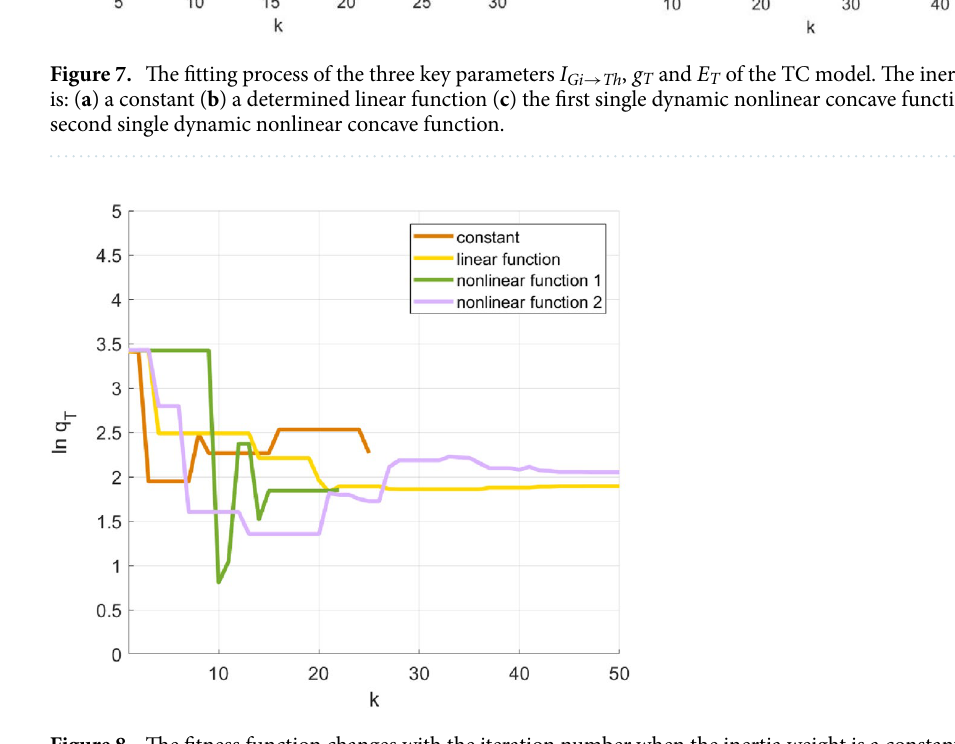
Figure 8. The fitness function changes with the iteration number when the inertia weight is a constant, a single determined linear function, and two sets of dynamic nonlinear concave functions